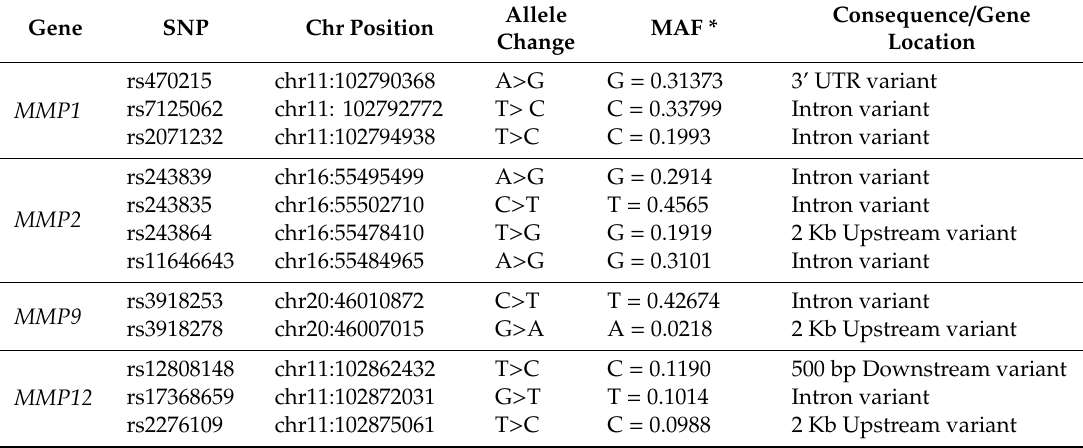
Table 1. Characteristics of single-nucleotide polymorphisms (SNPs)